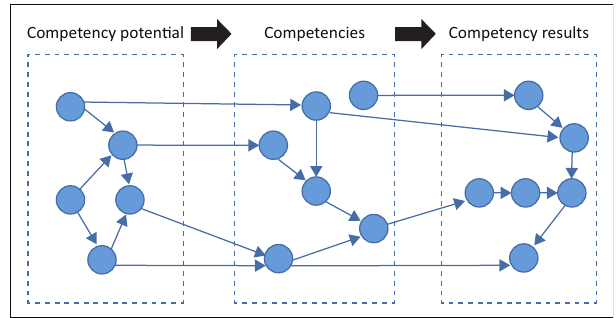
Competency poten(cid:21)al